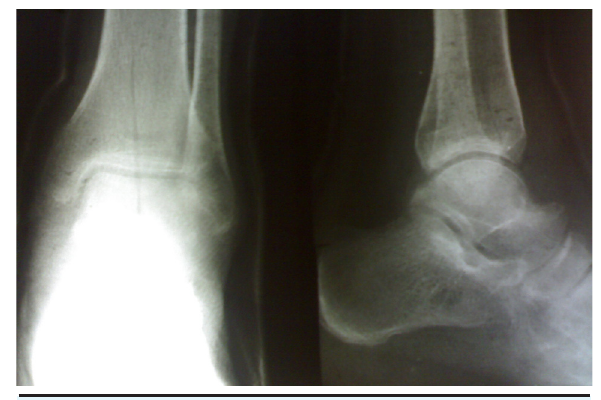
figure 1. Ankle x-ray: Anteroposterior and Lateral view.